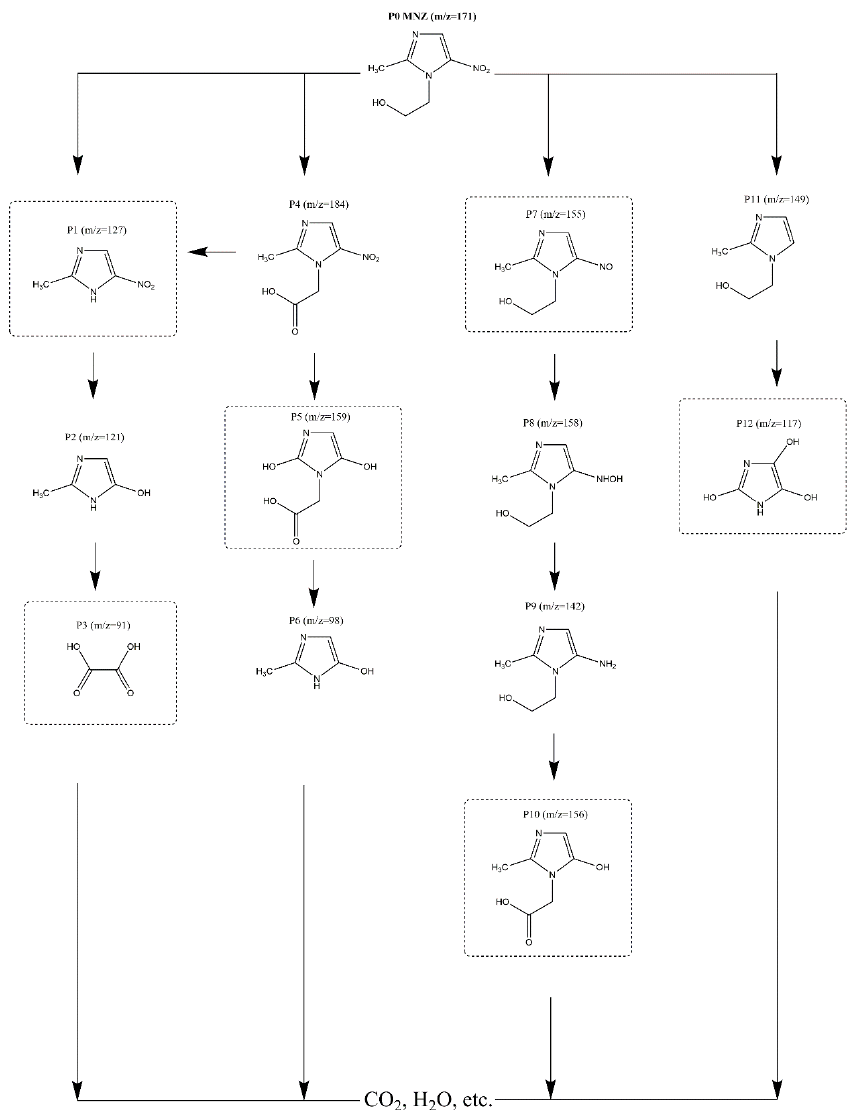
Figure 17. Degradation pathway of MNZ during the reaction. MNZ C 0 = 2 mg L − 1 , photocatalyst dosage = 0.1 g L − 1 .